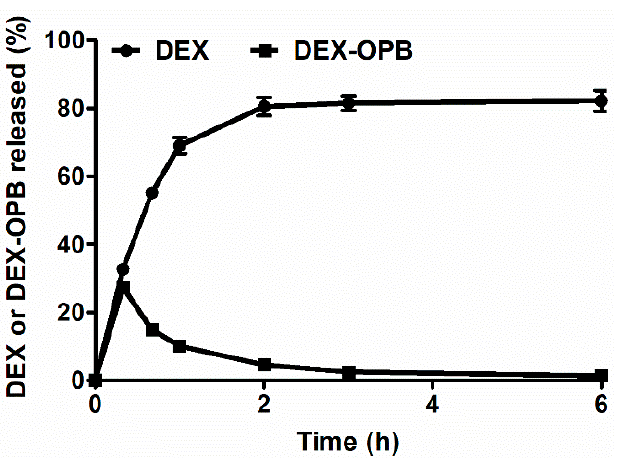
Figure 2. Release of the DEX-OPB/DEX in the presence of carboxylesterase.